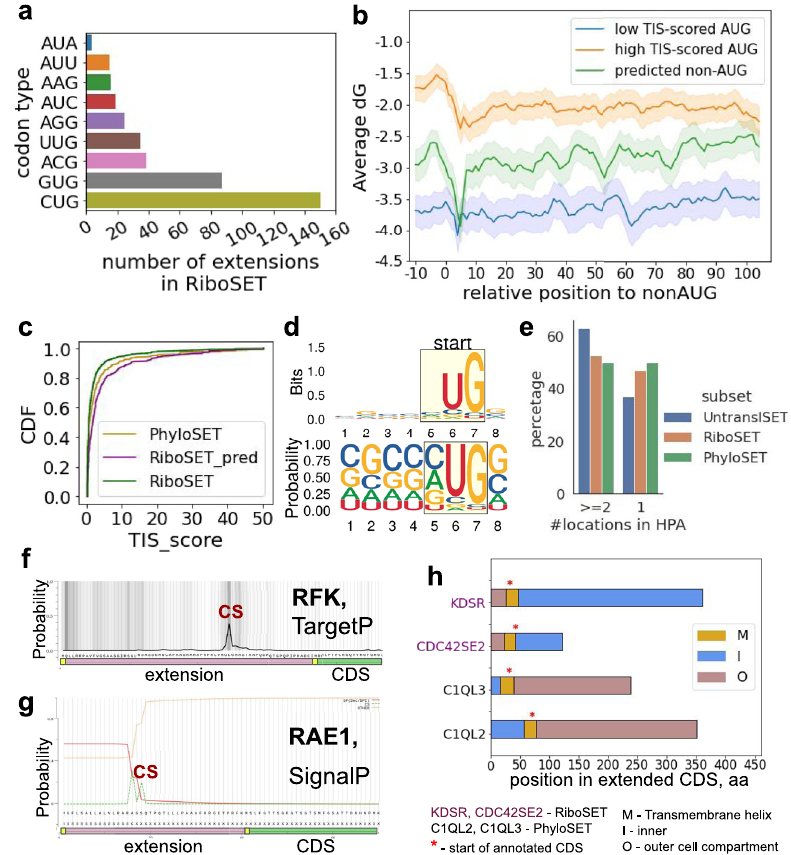
Fig. 4 | Characterisationofpredictednon-AUGinitiationcodons.a Distribution ofstartcodontypespredictedbyTrips-viz(RiboSET). b Thestability(dG,Gibbsfree energy) of mRNA secondary structure downstream of start codons within 22nt window ‘ 0 ’ corresponds to the start codon. 390 starts from RiboSET(green line), a sample of 400 AUG starts with high-scored TIS (blue line), a sample of 400 AUG starts with low-scored TIS (orange line). Lines are mean values across genes with 95% con fi dence intervals. c Cumulative distribution functions of TIS scores for all non-AUG codons in theoretical NTE, RiboSET (green), all non-AUG codons in the- oretical NTE, PhyloSET (yellow), Trips-viz predicted non-AUG starts, RiboSET